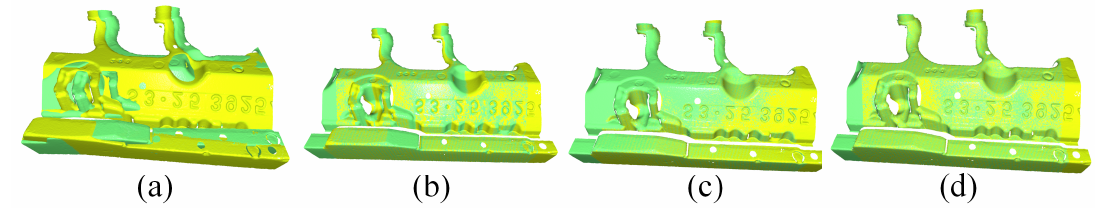
Figure 3. ( a ) Initial relative pose between source (green) and target (yellow) point cloud, ( b ) Registration result by only minimizing geometric error in Equation (8), ( c ) Point-to-plane ICP performed on 3D point cloud with a max distance threshold to eliminate outliers, ( d ) Minimizing both of the geometric error and curvature error as proposed in this